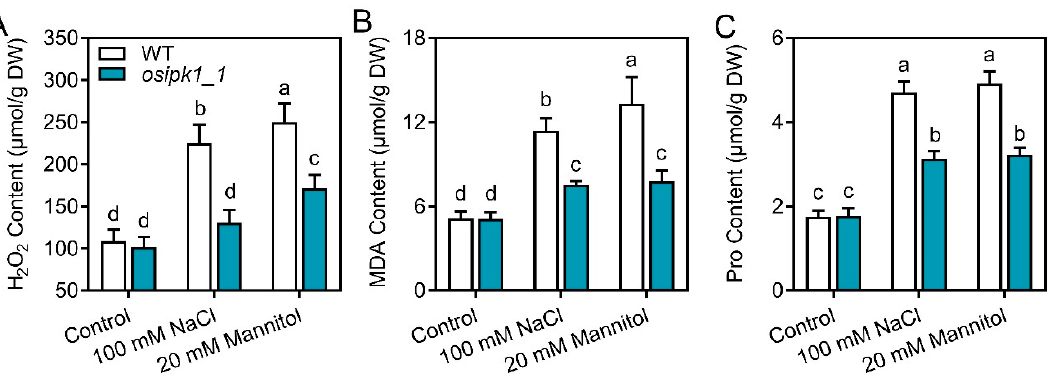
Figure 6. Levels of hydrogen peroxide (H 2 O 2 , A ), malondialdehyde (MDA, B ), and proline (Pro, C ) in Xidao #1 (WT) and its OsIPK1 mutant line osipk1_1 . All analyses were performed with three replicates. Error bars represent standard error. The different letters (a, b, c, and d) show the significant difference at a probability of p ˂ 0.05.